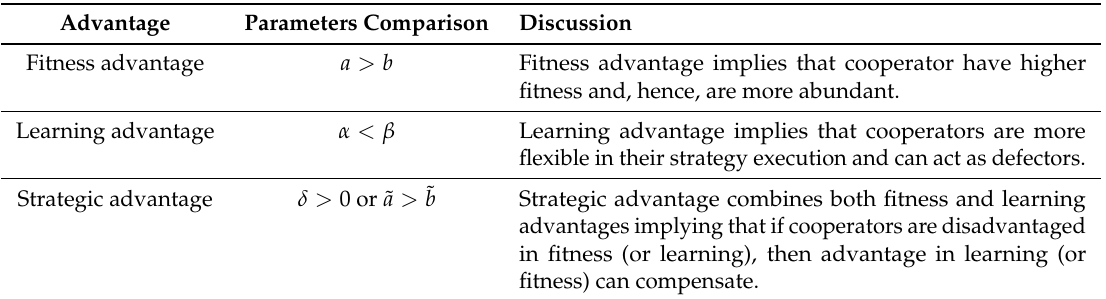
Table 1. Definitions of advantages of cooperators over defectors. For the definition of advantages of defectors over cooperators, the inequality signs in parameters comparison should be